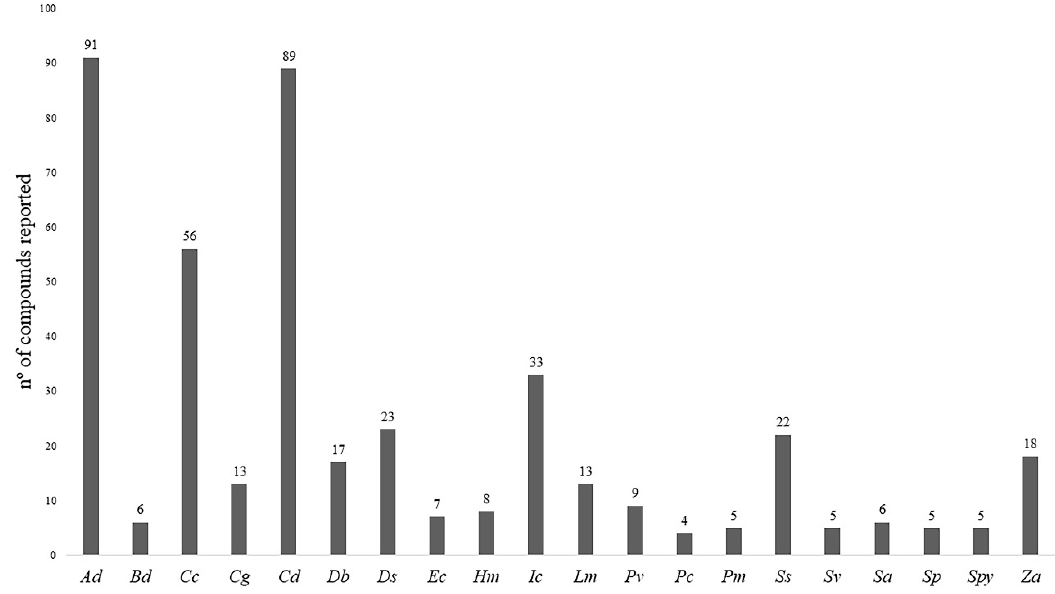
Figure 1. Total number of compounds reported in each species of halophytic grasses. Being, Ad : Arundo donax; Bd : Buchloe dactyloides ; Cc : Cenchrus ciliaris ; Cg: Chloris gayana ; Cd : Cynodon dactylon ; Db : Desmostachya bipinnata; Ds : Distichlis spicata ; Ec : Echinochloa crus-galli; Hm : Halopyrum mucronatum ; Im : Imperata cylindrica ; Lm : Lolium multiflorum ; Pv : Panicum virgatum ; Pc : Pennisetum clandestinum ; Pm : Puccinellia maritima ; Ss : Saccharum spontaneum ; Sv : Setaria viridis ; Sa : Spartina anglica ; Sp : Spartina patens ; Spy : Sporobolus pyramidalis and Za : Zizania aquatica .